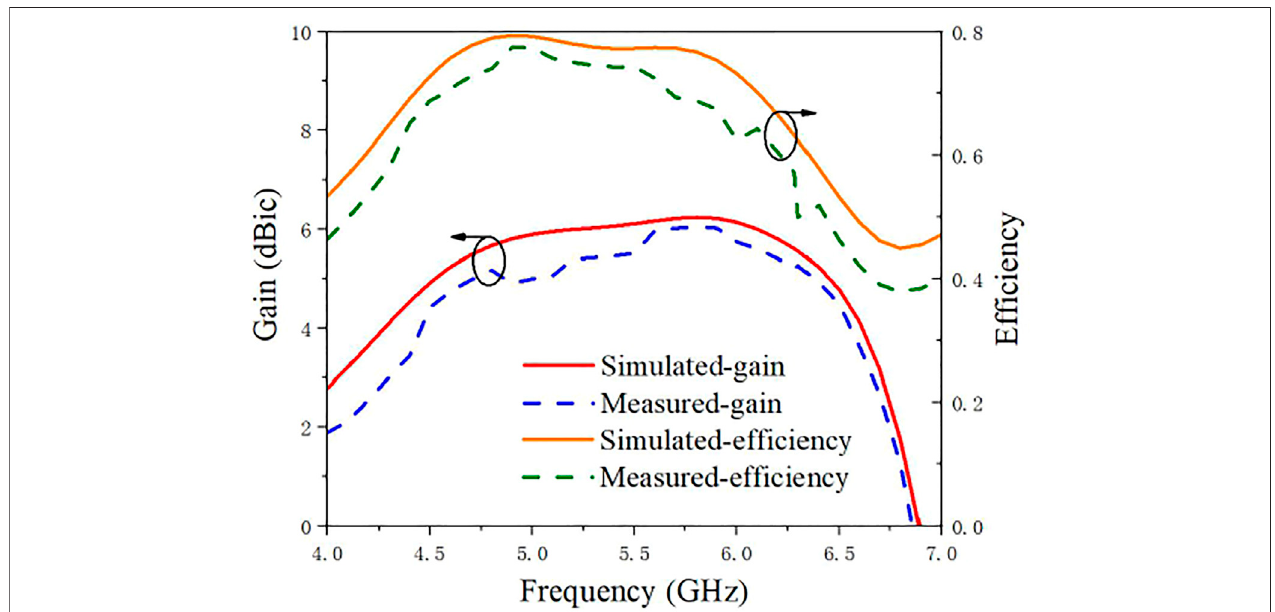
FIGURE 12 | Simulation and measurement of the gain and ef fi ciency of the proposed antenna.